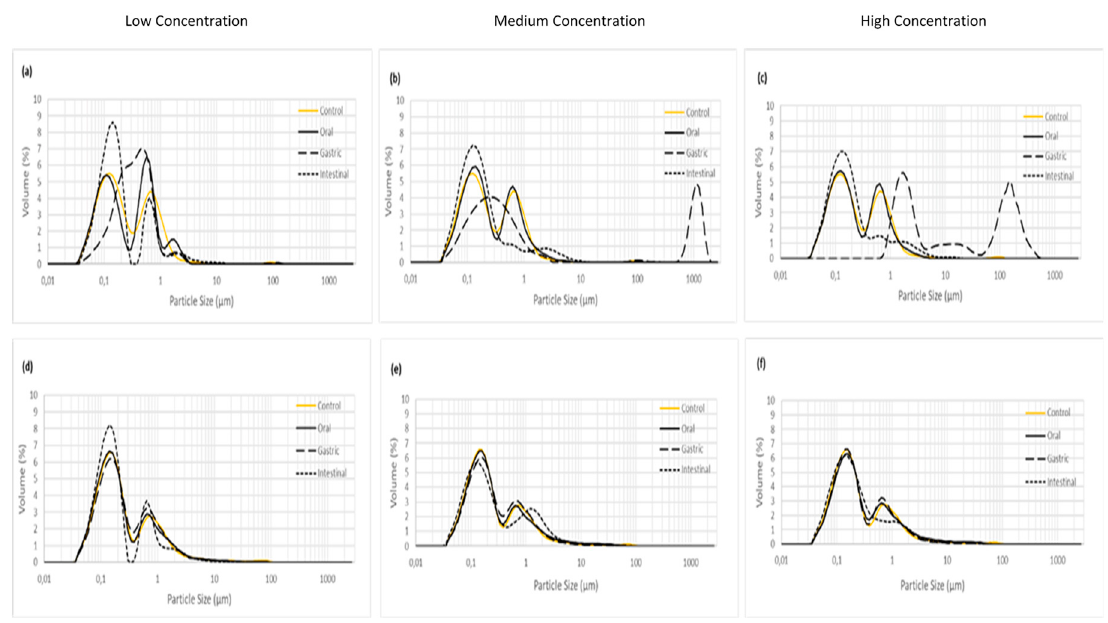
Figure 2. Degree of aggregation/fragmentation during in vitro digestion, ( a – c ) correspond to xanthan gum and ( d – f ) correspond to mucilage from chia